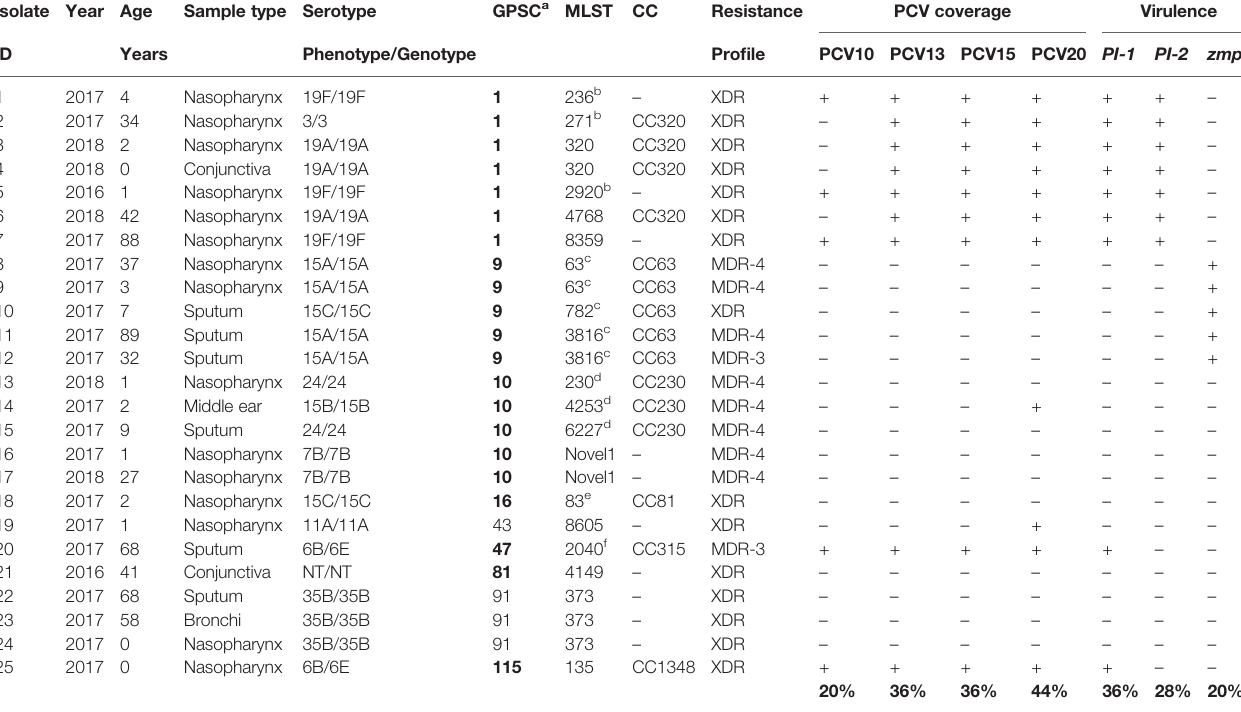
TABLE 1 | XDR and MDR isolates were closely related to international MDR lineages.